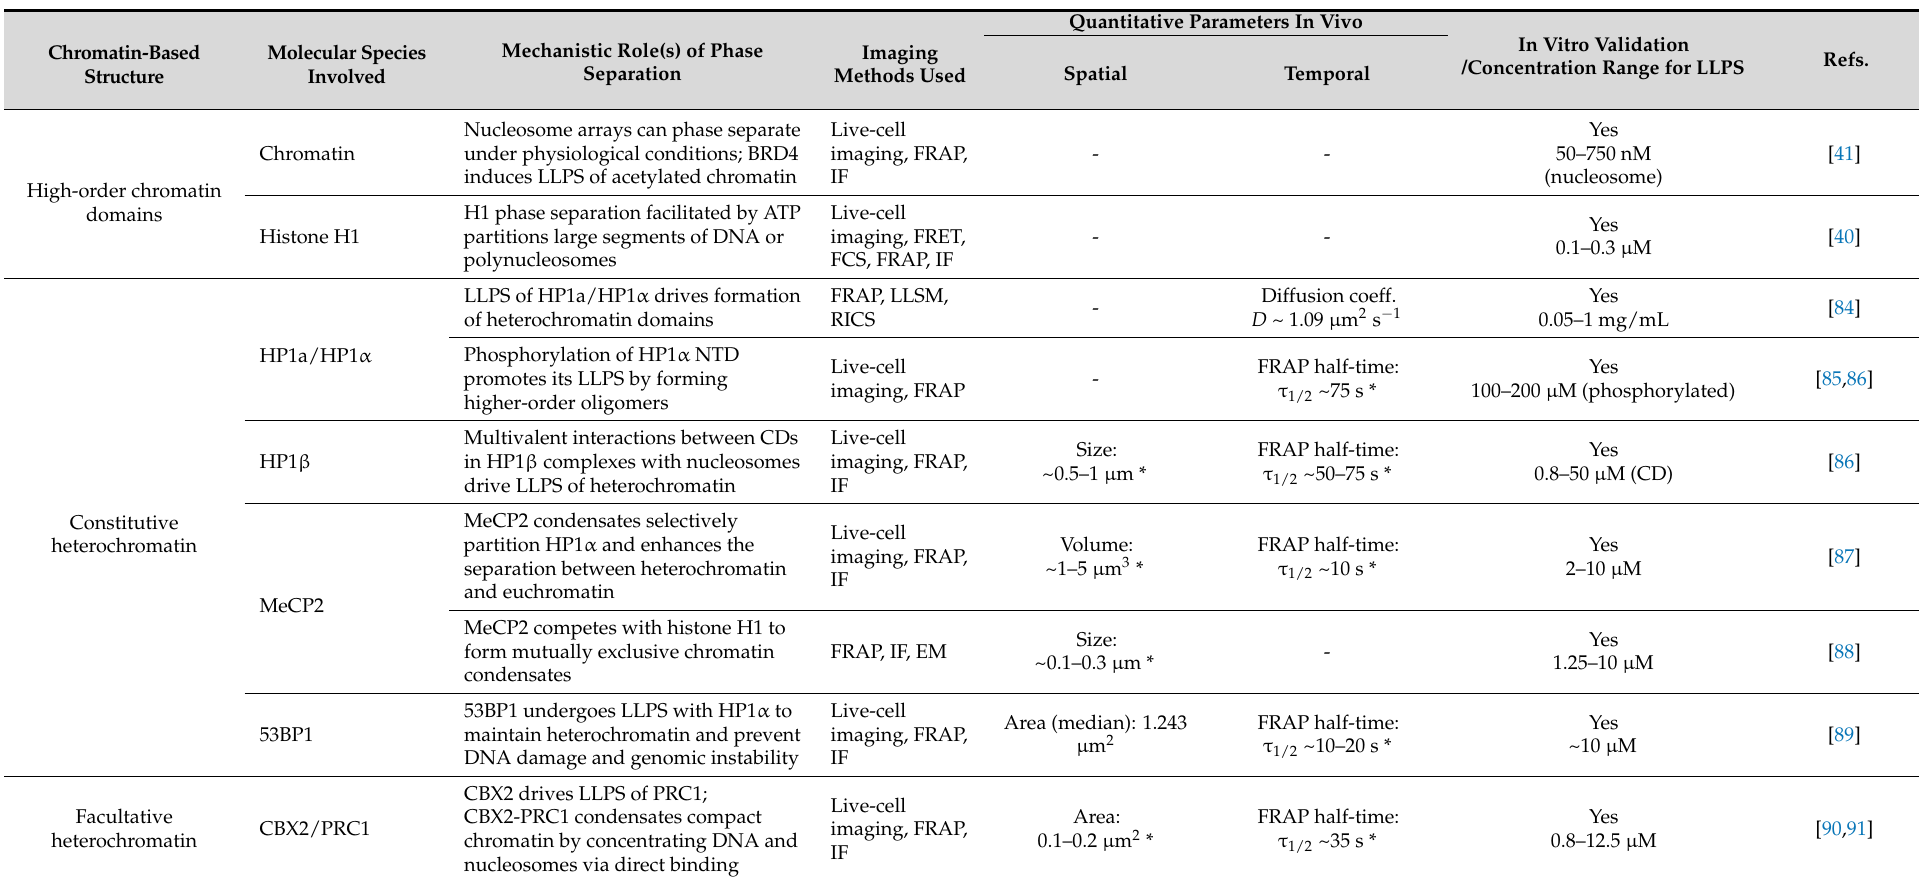
Table 2. Various phase separation-mediated chromatin structures and processes, the molecular players involved in them, as well as their quantitative characterizations using different imaging